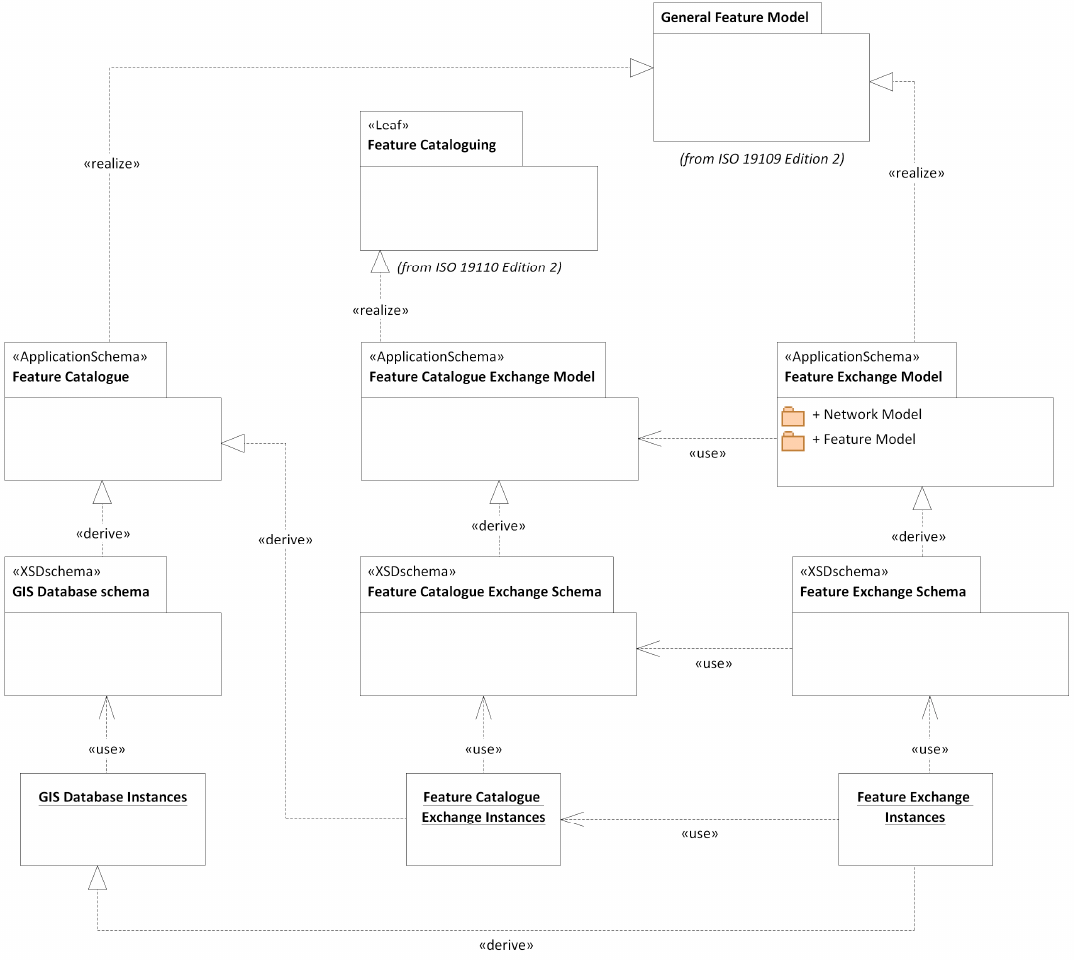
Figure 4. Prototype concepts.